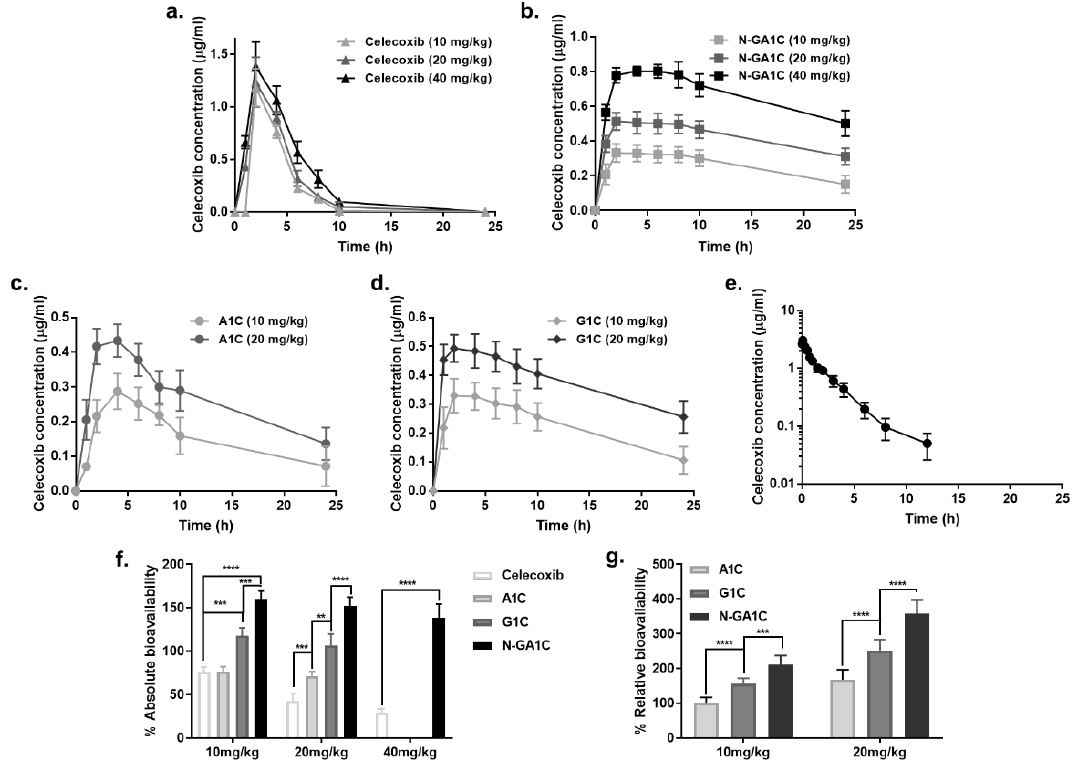
Figure 4. Celecoxib derivatives improve the PK properties of celecoxib. ( a – e ), Plasma concentration of celecoxib after the oral administration of celecoxib ( a ), N-GA1C ( b ), A1C ( c ), or G1C ( d ). ( e ), Plasma concentration of celecoxib after the intravenous administration of celecoxib. ( f – g ), Absolute bioavailability ( f ) and relative bioavailability ( g ) of A1C, G1C, and N-GA1C after the oral administration of celecoxib, A1C (equivalent mass of celecoxib), G1C (equivalent mass of celecoxib), or N-GA1C (equivalent mass of celecoxib) to Sprague-Dawley rats. Data are presented as mean ± s.e.m. from a representative experiment ( n = 5) from 3 independent experiments. ** p < 0.01, *** p < 0.001, and **** p < 0.0001, analyzed by two-way ( a – d ) or one-way ( e – f ) ANOVA with Tukey’s HSD multiple comparison post hoc test. Table 2. Pharmacokinetic profiles of celecoxib, A1C, G1C, and N-GA1C. Absolute bioavailability and relative bioavailability were calculated using the following equations: Absolute bioavailability (F, %) = [(AUC 0–∞ )PO/dose PO]/[(AUC 0–∞ )IV/dose IV]; Relative bioavailability (%) = [(AUC0–∞)A/dose A]/[(AUC 0–∞ )B/dose B].